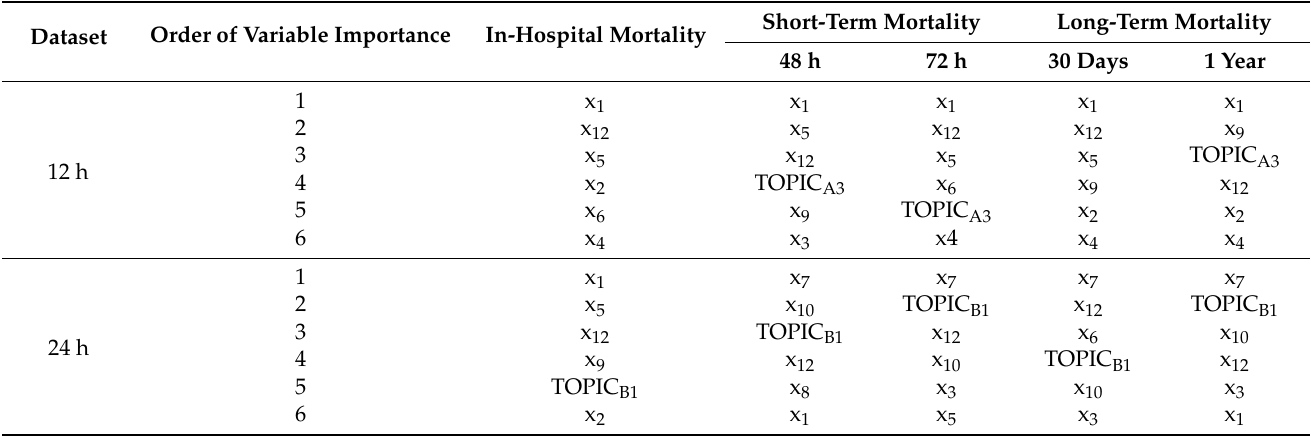
Table 8. The selected six important variables for 12 h and 24 h datasets by using GB. Dataset Order of Variable